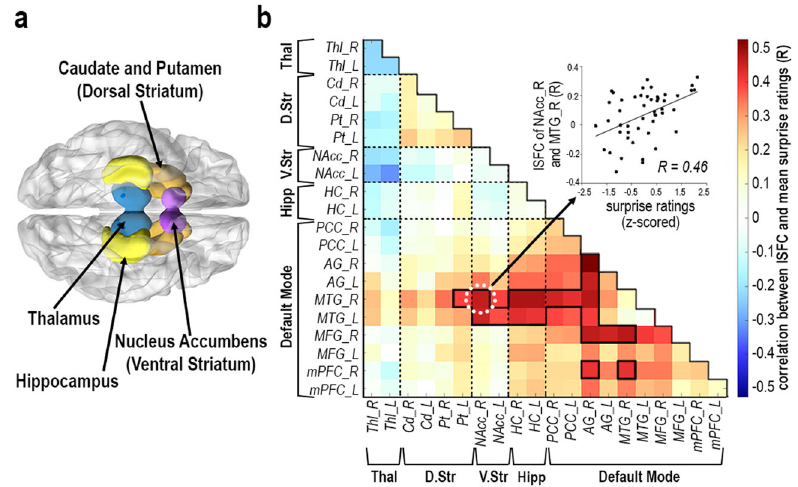
Fig. 4 Correlation between surprise ratings and cortical-subcortical coactivations in Sherlock. a Brain-map denoting hippocampus (HC; yellow), nucleus accumbens (NAcc; ventral striatum: purple) caudate and putamen (Cd and Pt; dorsal striatum: Orange), thalamus (Thl; blue). b Correlation SFPA — Pearson correlations were calculated between surprise ratings (mean of 45 behavioral participants) and ISFC of each region-pair (mean of 35 fMRI participants), across the time-course of n = 49 movie events. Black outlines denote above-chance correlations at p < 0.05 (corrected), determined by random permutation testing (1000 iterations). Scatterplot illustrates the correlation between mean surprise and mean ISFC of the right middle temporal gyrus (MTG) and NAcc across movie events. Default mode network regions of interest: PCC posterior cingulate cortex, AG angular gyrus, MTG middle temporal gyrus, MFG middle frontal gyrus, and mPFC medial prefrontal